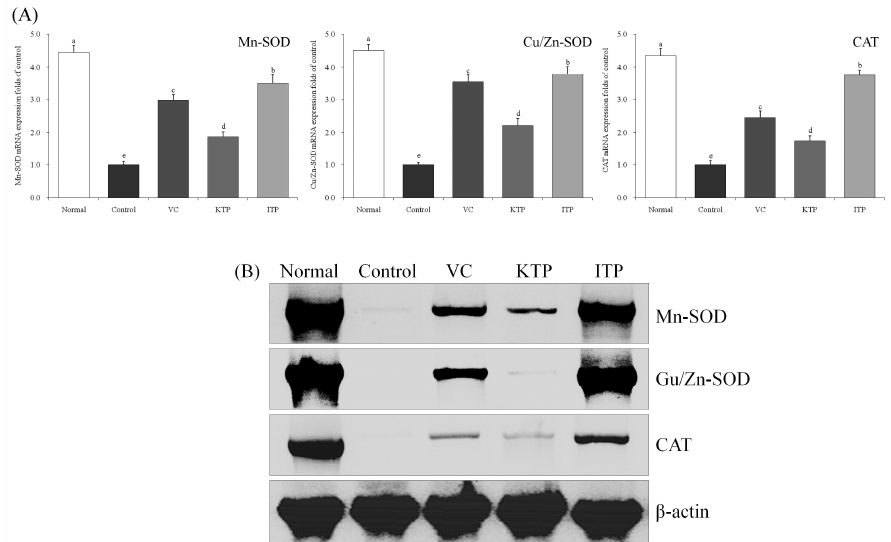
Figure 7. Expression of mRNA ( A ) and protein ( B ) for Mn-SOD, Cu/Zn-SOD and CAT in spleen of mice. a–e Mean values with different letters in the same bar represent significant differences ( p < 0.05) according to Duncan’s multiple-range test. VC: vitamin C (200 mg/kg body weight); KTP: Kuding tea polyphenols (200 mg/kg body weight); ITP: insect tea polyphenols (200 mg/kg body weight).